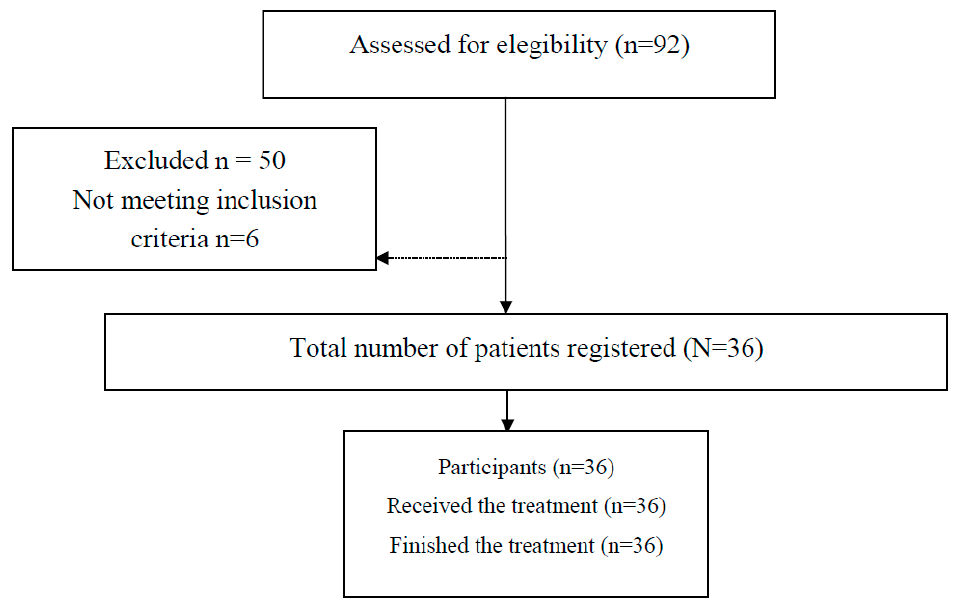
Figure 1. Study design flowchart.